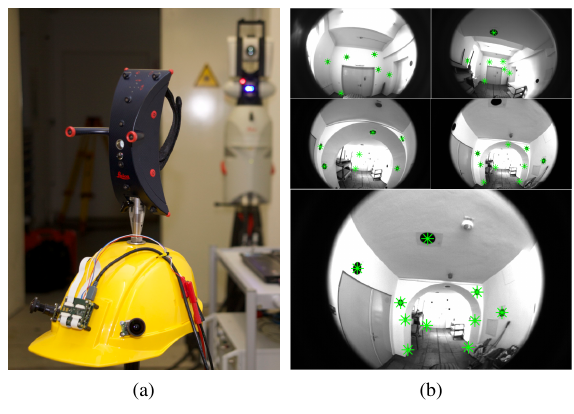
Figure 4. (a) Camera system with mounted T-Probe. The back- ground shows the lasertracker. (b) Some images taken from the trajectory. Tracked world points are depicted in green. For each frame t in the trajectory, the epicenters of I passpoints (planar, black filled circles) are tracked over time, as depicted in Fig. 4b. The number of passpoints I , that are visible in each frame ranges from 6 to